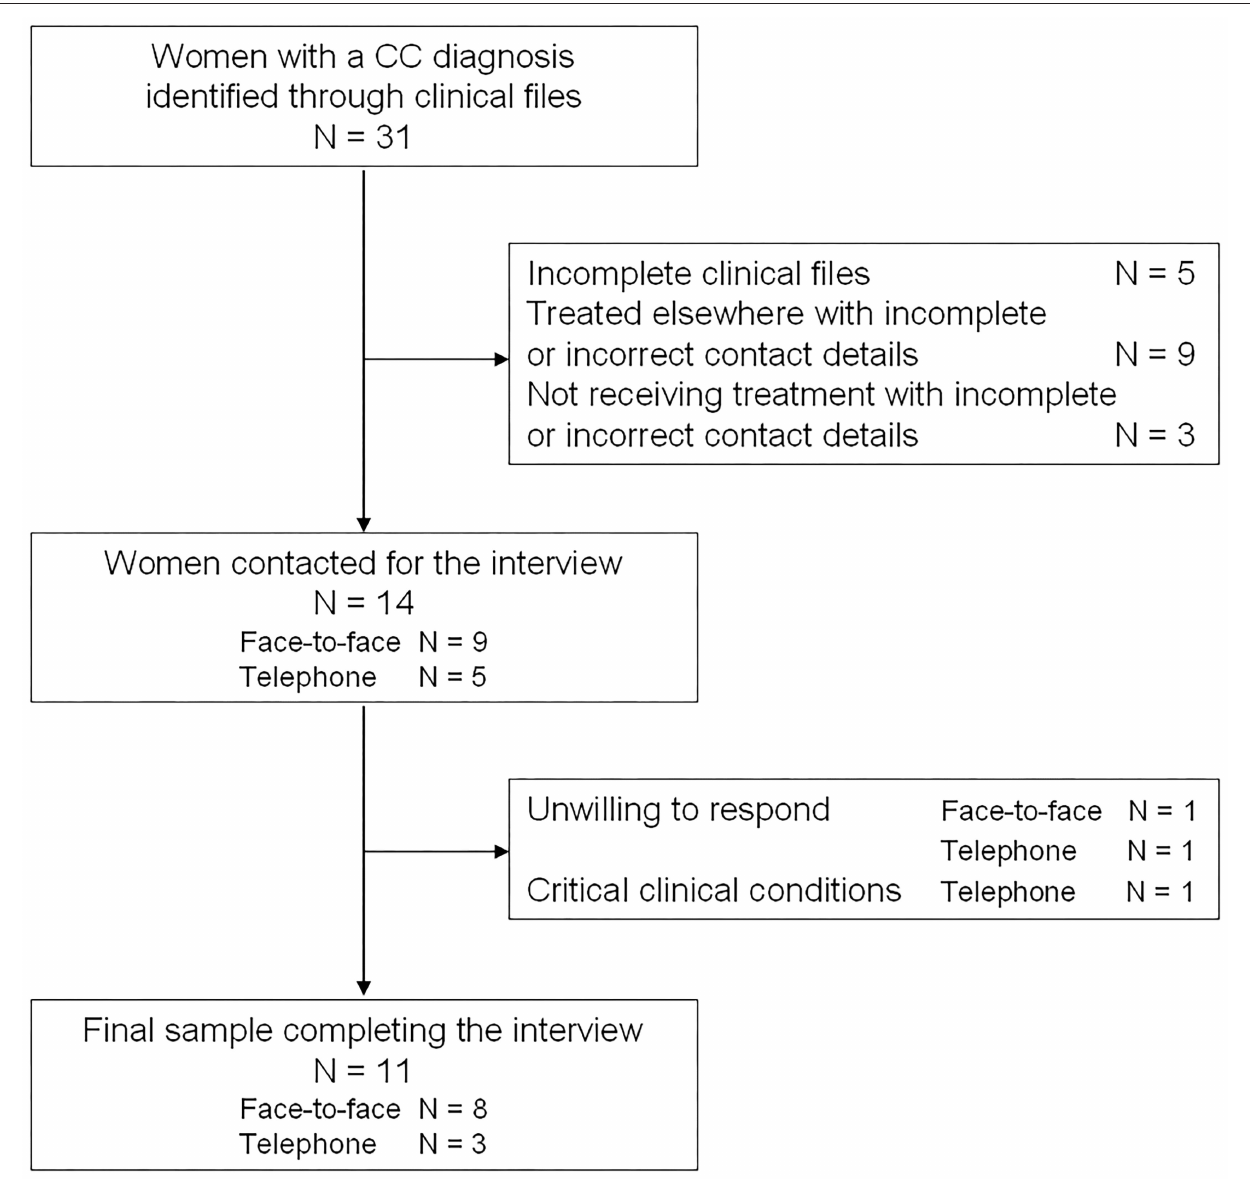
FIGURE 1 | Flow-chart of study